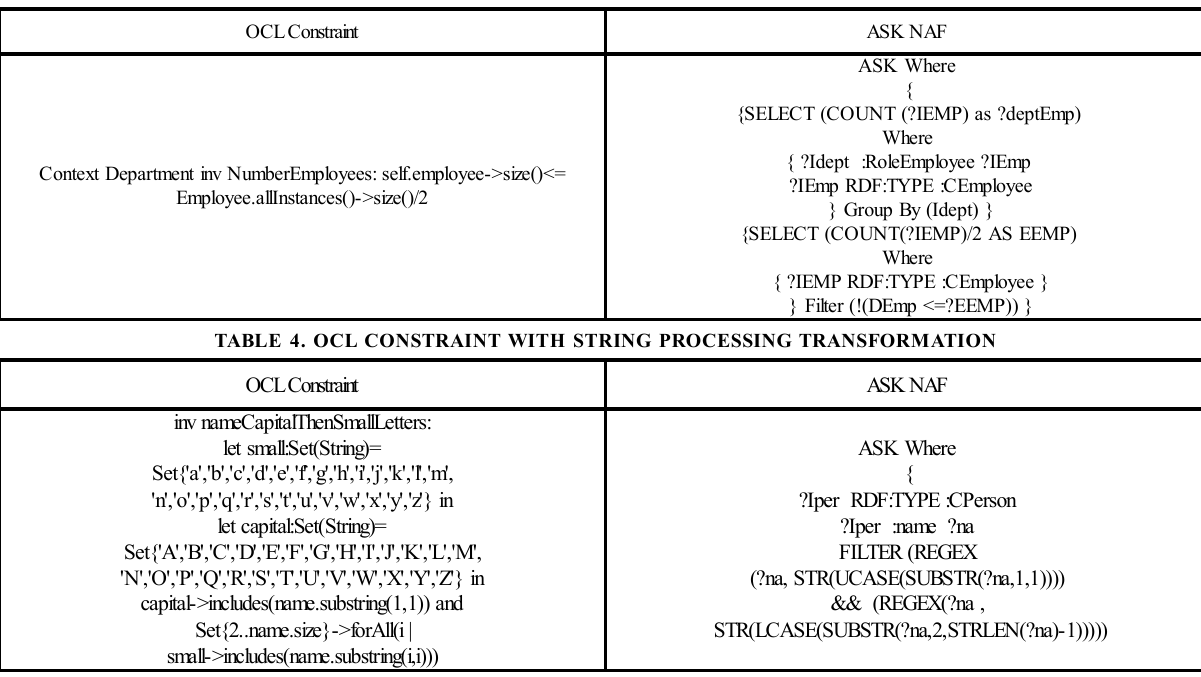
TABLE 3. TRANSFORMATION OF GLOBAL CONSTRAINT WITH ARITHMETIC COMPUTATION